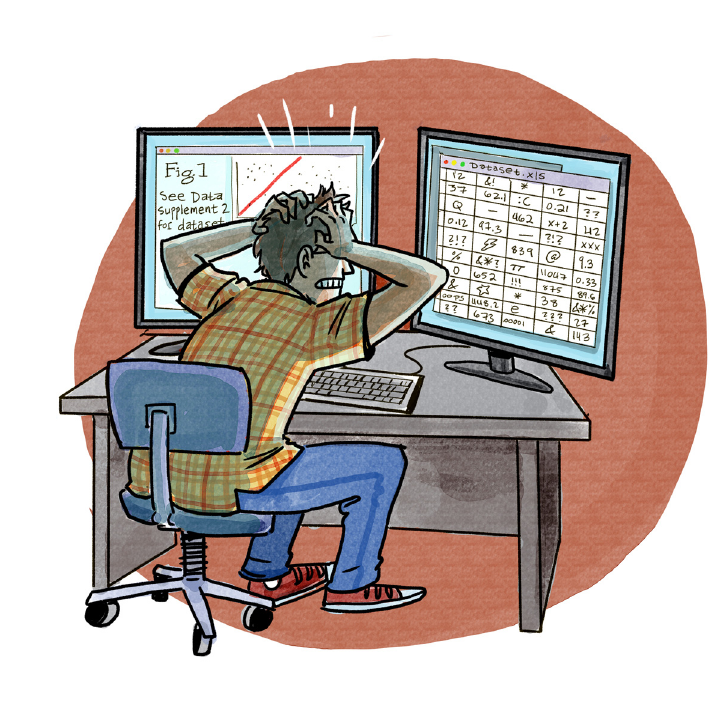
Fig 1. How complete and reusable are publicly archived data in ecology and evolution? The expectation of PDA that exists in genetics and molecular biology is rapidly permeating throughout ecology and evolution. With the advent of data archiving policies and integrated data repositories, journals and funders now have effective means of mandating PDA. However, the quality of publicly archived data associated with experimental and observational (nonmolecular) studies in ecology and evolution is highly variable. Illustration by Ainsley